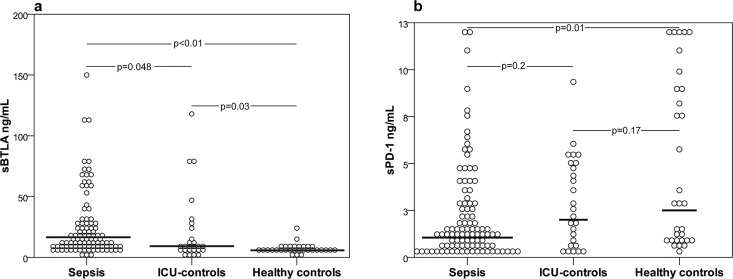
Plasma sBTLA and sPD-1 concentrations at baseline in the sepsis cohort, ICU controls and blood donors.(a) sBTLA concentrations in the sepsis cohort (median 14 ng/mL, IQR 8–29), ICU controls (median 9 ng/mL, IQR 5–26) and HC (median 5 ng/mL, IQR 5–8). (b) sPD-1 concentrations in the sepsis cohort (1.3 ng/mL, IQR 0.6–5.8), ICU controls (2.4 ng/mL, IQR 0.7–5) and HC (2.9 ng/mL, IQR 0.9–9.1). Bars indicate median concentrations. Linear regression with markers on log10 scale as outcome gave the following age-adjusted p-values: sBTLA: sepsis vs HC (p<0.01), ICU controls vs HC (p = 0.02) and sepsis vs ICU controls (p = 0.03). sPD-1: sepsis vs HC (p<0.01), ICU controls vs HC (n.s.) and ICU controls vs sepsis (p = 0.27). P-values in figure and text are adjusted with the Bonferroni-Holm method.